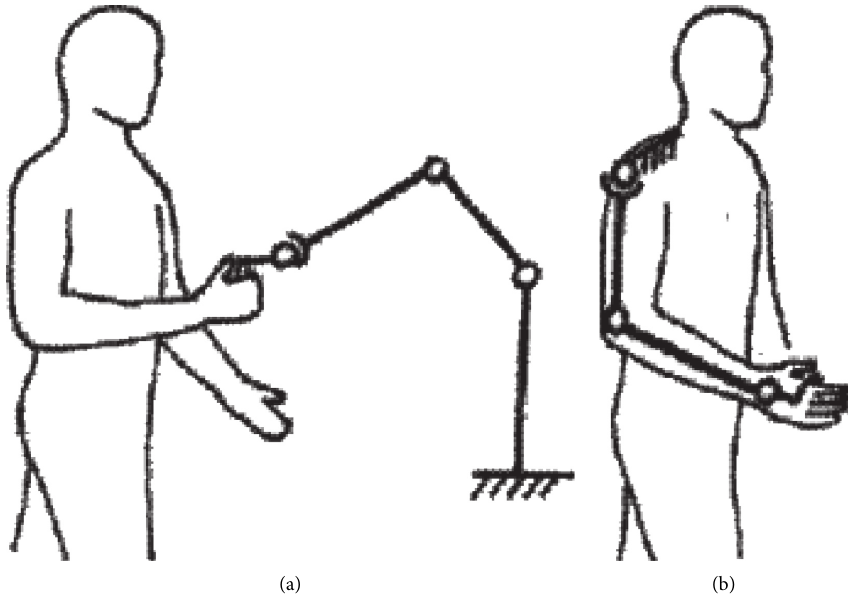
Figure 6: (a) End-effector-based robotic device and (b) exoskeleton robotic device